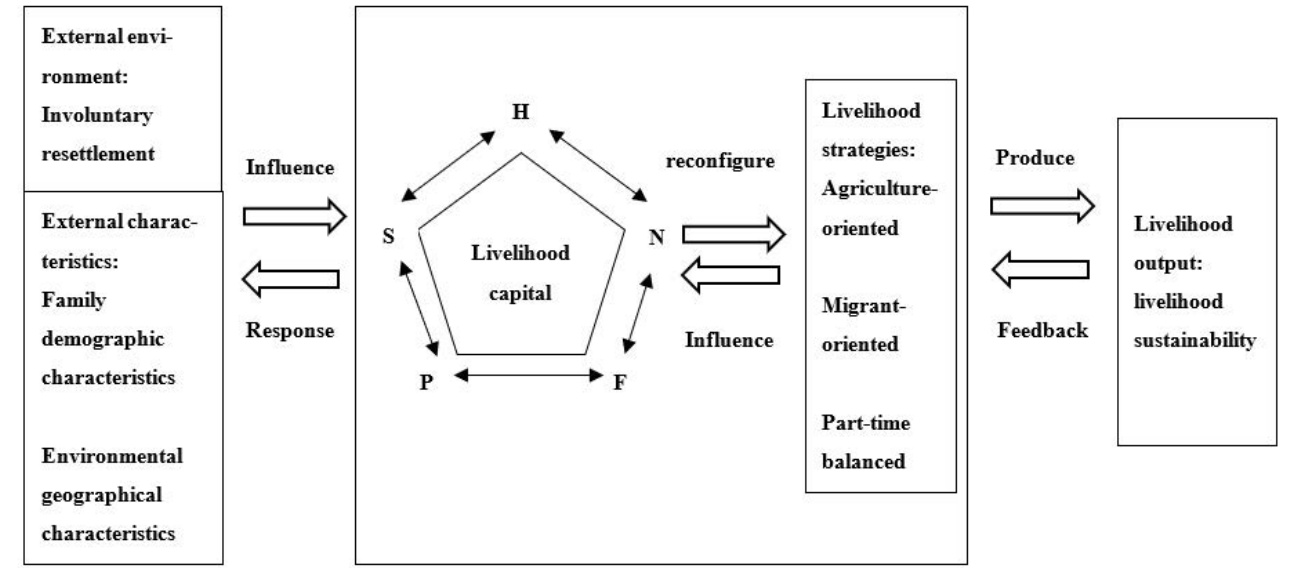
Figure 1. Schematic diagram of the influence of livelihood capital on livelihood strategies in the context of involuntary resettlement. Source: Created by the authors.